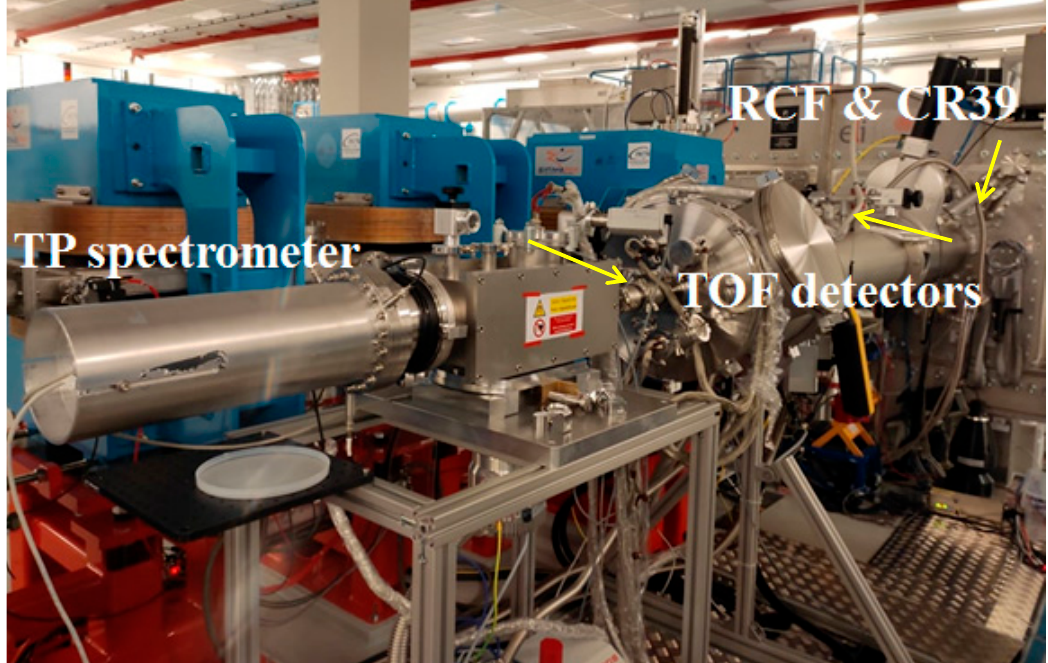
Figure 20. Photograph of the ion diagnostics station connected to the ECU ‐ D2 chamber (the blue electromagnets of the ELIMED Beamline are also visible).